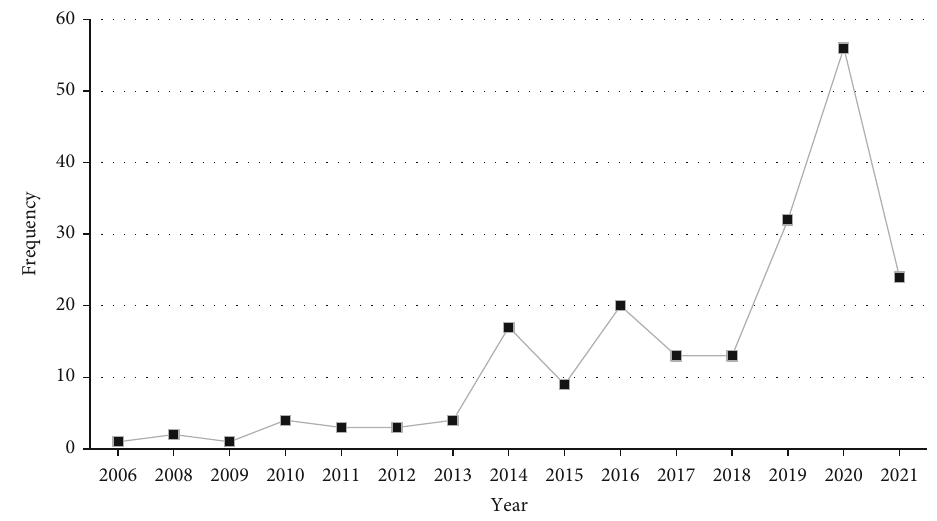
Figure 3: Distribution of YouTube content regarding hydroponic technology based on publishing